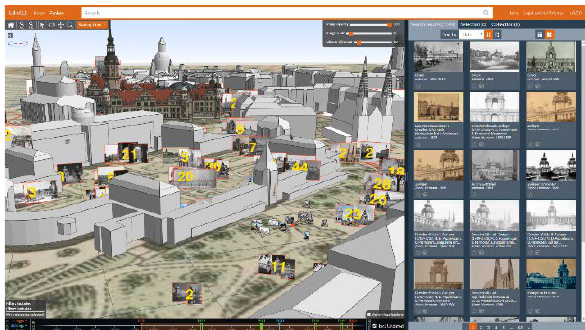
Figure 1. 4D Browser with location-based photographs, map underlay and timeline